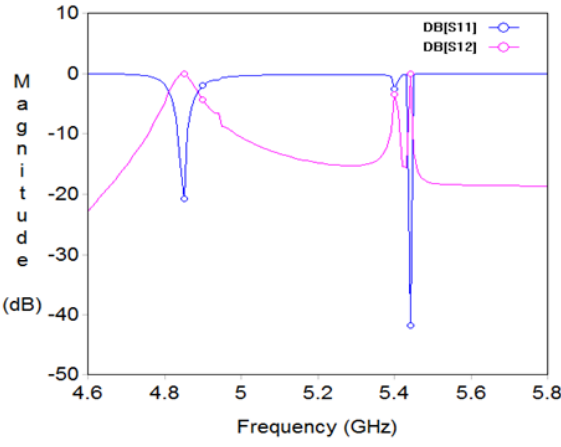
Figure 2. Output signal of the dual band pass filter